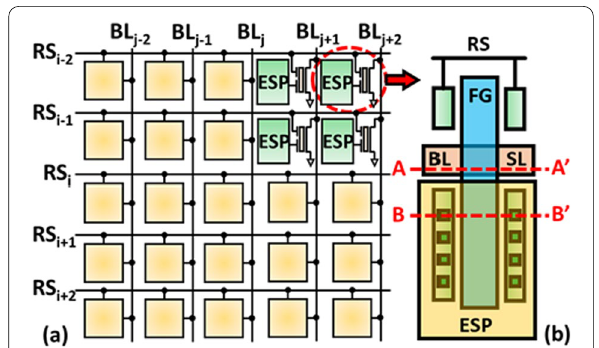
Fig. 2 a The schematic of the proposed high‑density micro‑detectors and b the top‑view layout of the 1 T pixel consist of a single floating gate